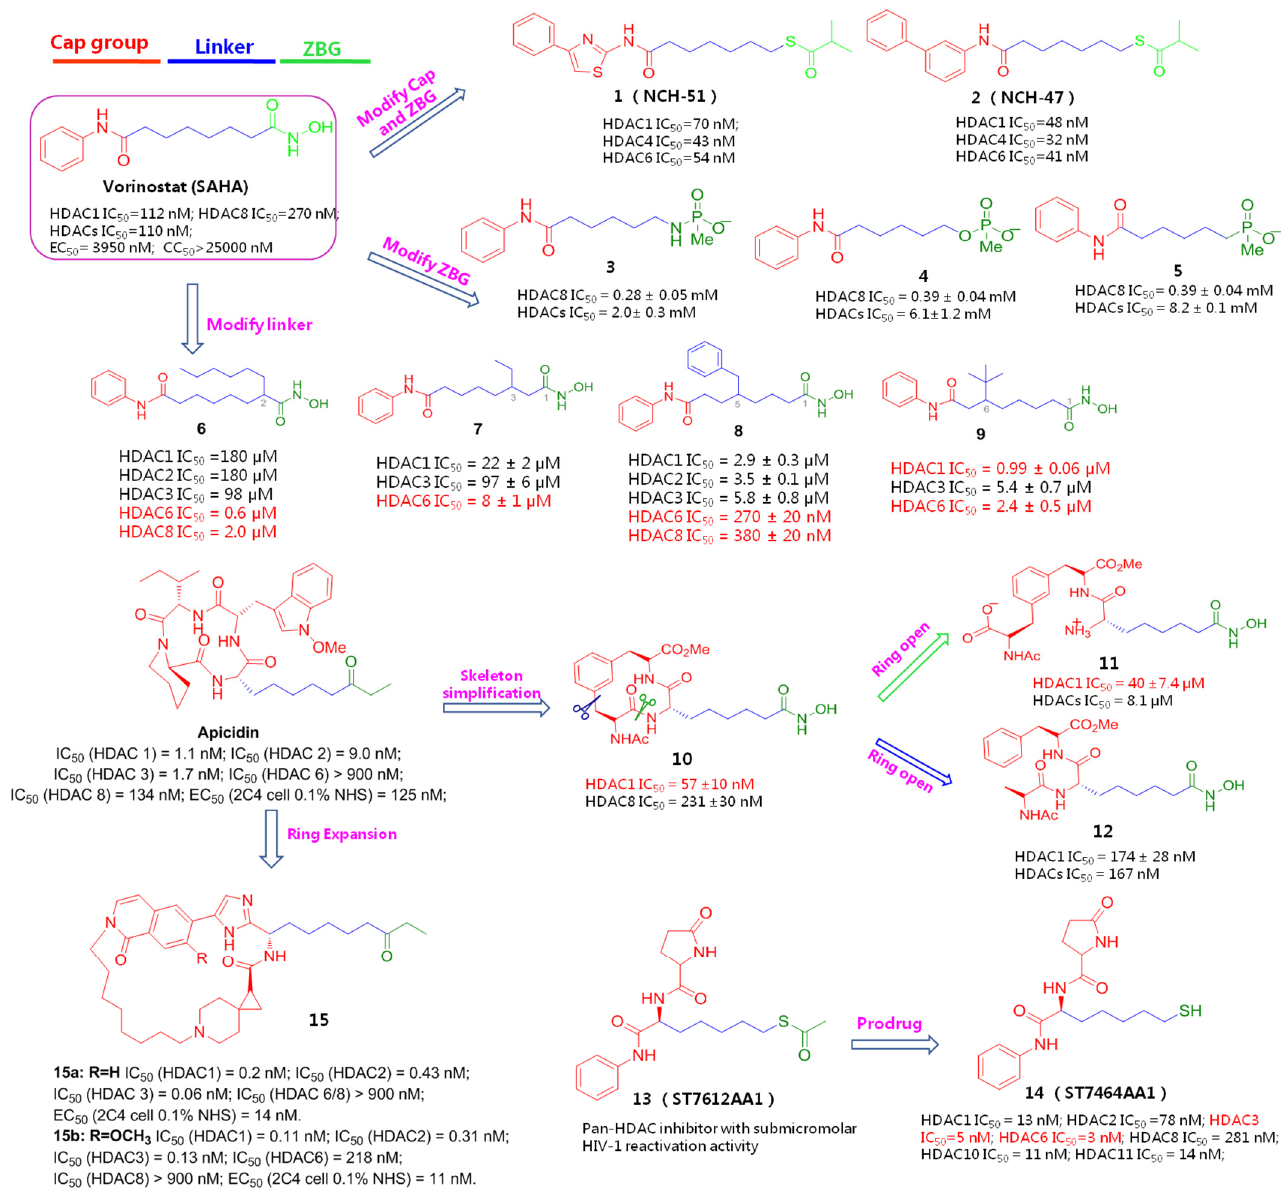
Figure 2. Chemical structures, HDAC inhibitory potencies and latency-reversing activities of a spectrum of HDACIs derived from SAHA or Apicidin.